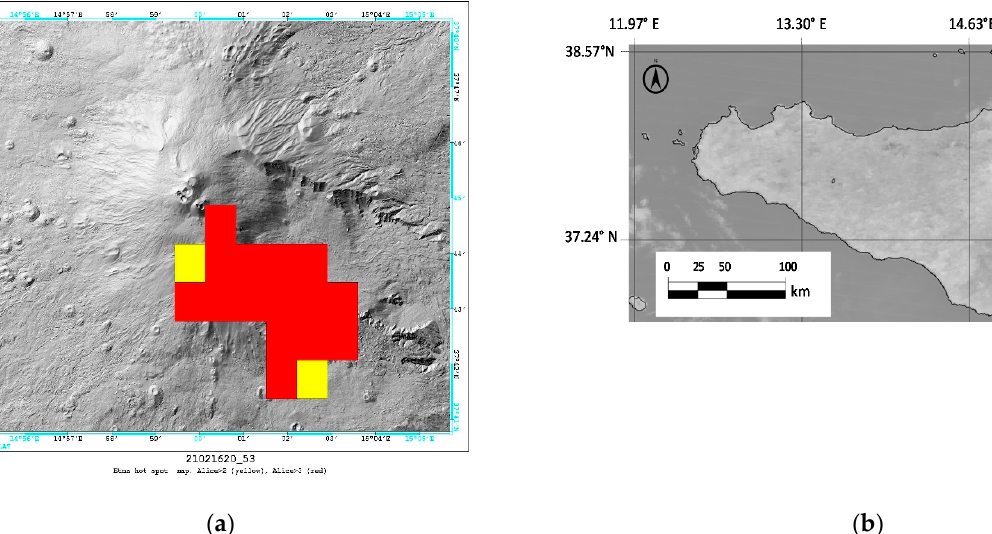
Figure 6. ( a ) Thermal anomaly map automatically generated at IMAA-CNR from the night-time AVHRR overpass of 16 February at 20:51 UTC (i.e., after the end of the 1st paroxysm), red and yellow pixels, respectively, indicate the areas where thermal emissions were stronger or less intense; ( b ) The thermal anomaly (in red) detected by RST VOLC over the Mt. Etna area on the daytime MODIS scene of 1 April at 09:33 UTC (channel 22 in the background) leading to the peak of radiative power in Figure 5.